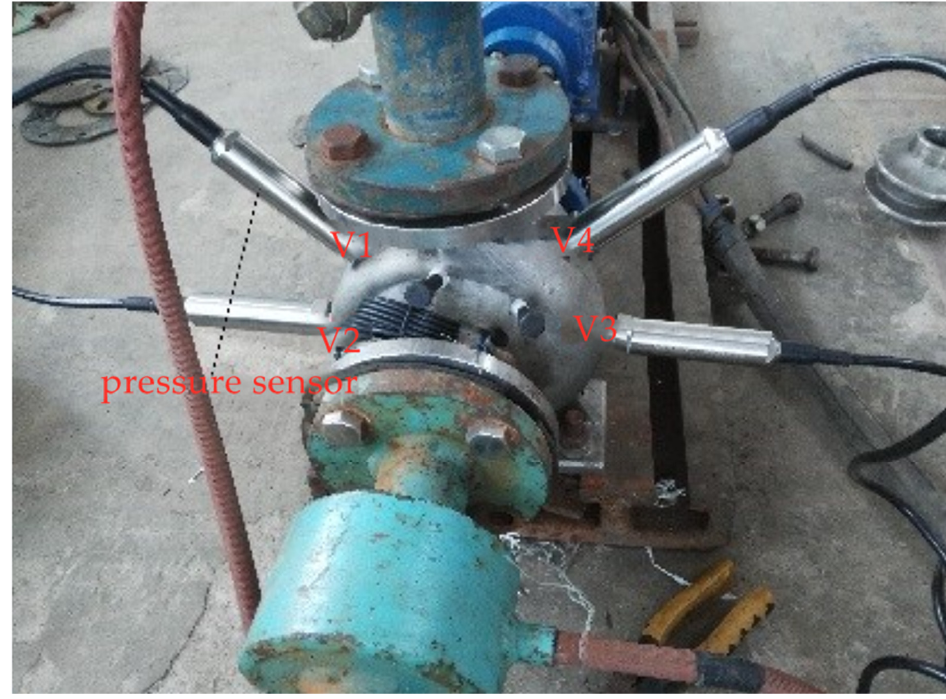
Figure 4. Pressure sensors distribution.